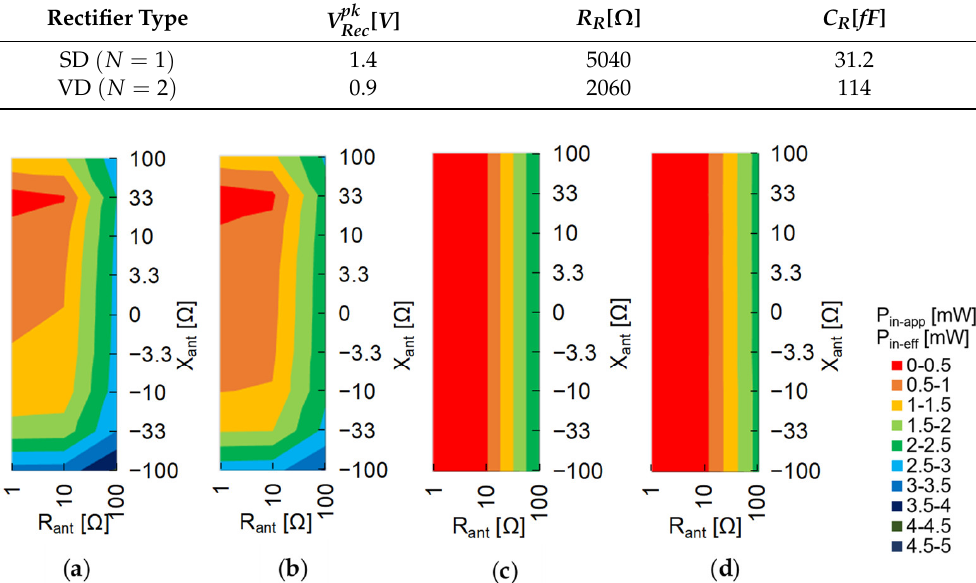
Figure 11. Contour plots of the input power in case of Model 1 with limited impedance points: ( a ) model calculation of P in − app , ( b ) SPICE simulation of P in − app , ( c ) model calculation of P in − ef f , ( d ) SPICE simulation of P in − ef f .